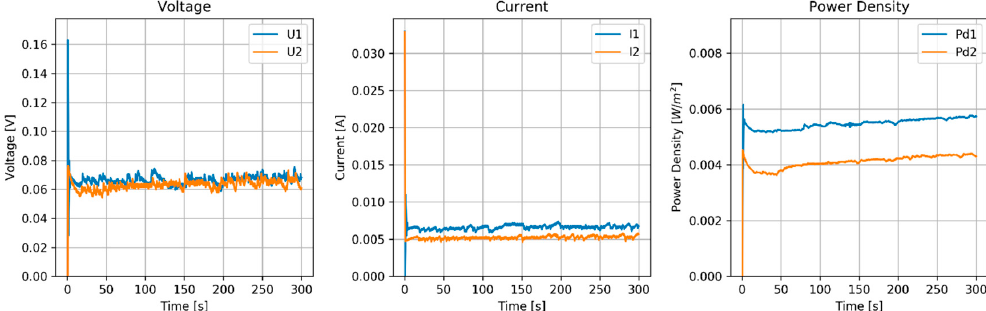
Figure 9. Results of MPPT test of the RED stack equipped with pseudo AEMs (Ag/AgCl) and pseudo CEMs (Zn). Flow rate (H and L) is 60 mL/min.